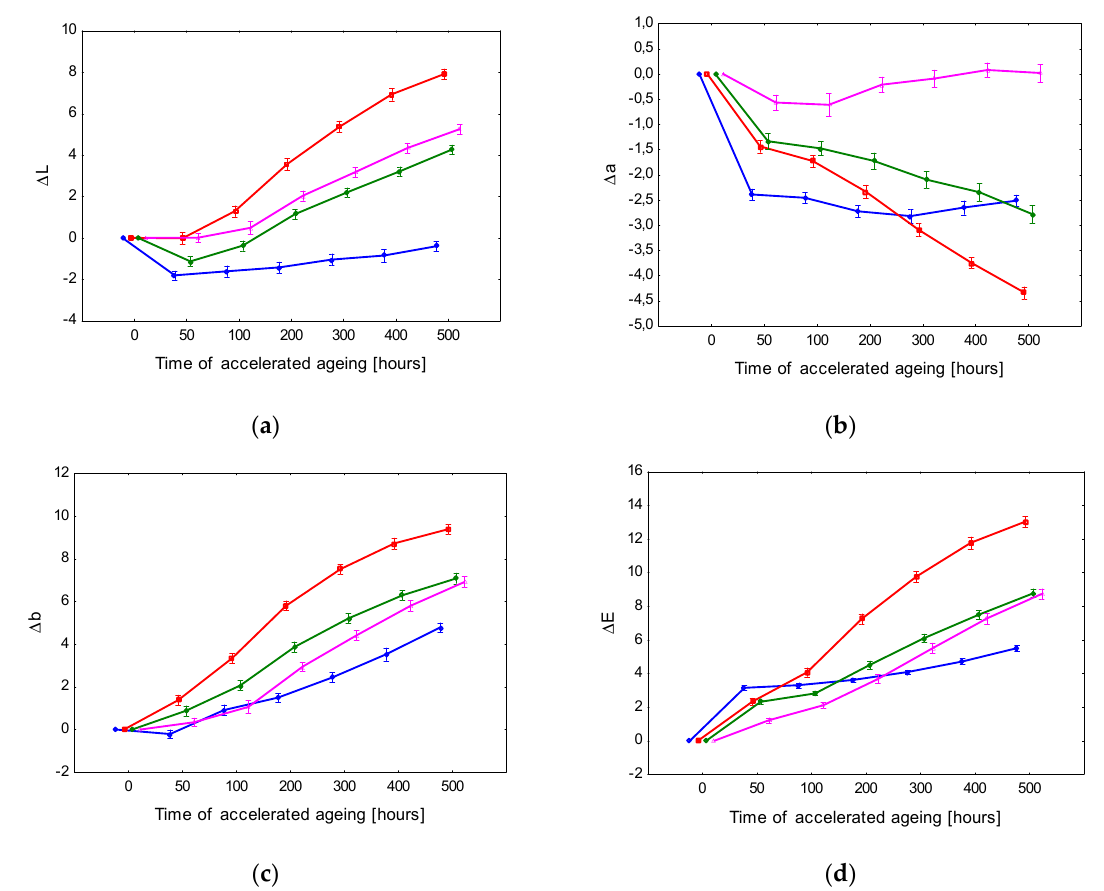
Figure 5. Accelerated-aging-induced differences in colour coordinates ( a ) Δ L* , ( b ) Δ a* , and ( c ) Δ b* , and the total colour difference ( d ) Δ E* of oak wood surface finished with polyurethane lacquers on surfaces with pigment mordants. Table 5. Basic statistical characteristics of colour coordinates L* , a* , and b* corresponding to different phases of accelerated aging of oak wood surfaces treated with solvent-based polyurethane lacquers. (The number of measurements in each set: n = 50.)